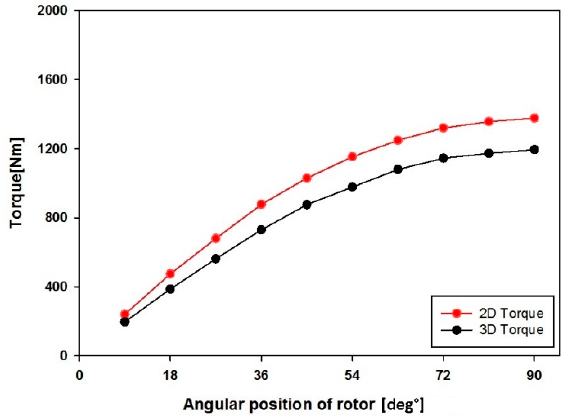
Figure 19. Torque (2D and 3D) versus angular position of rotor.